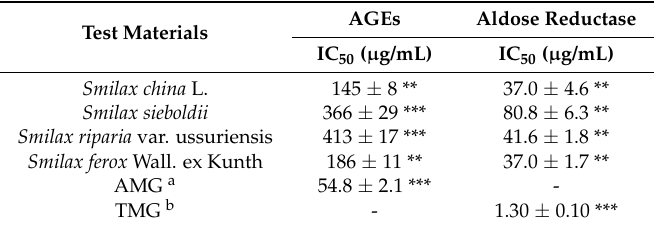
Table 1. Inhibition of AGEs formation and AR activity by 70% MeOH stem extracts of selected members of the family